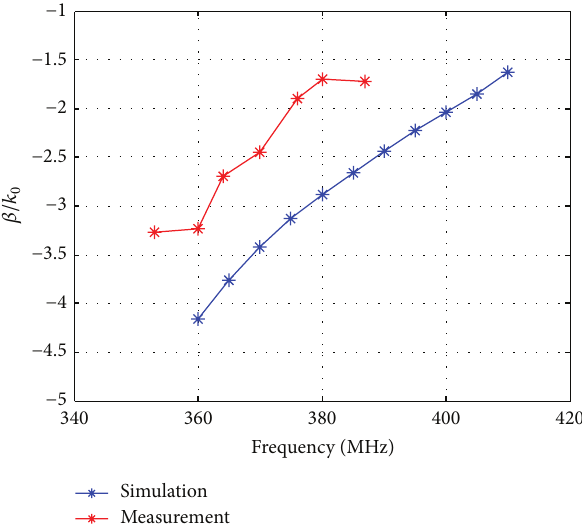
Figure 7: Extracted phase constants of simulation and measurement against frequency.